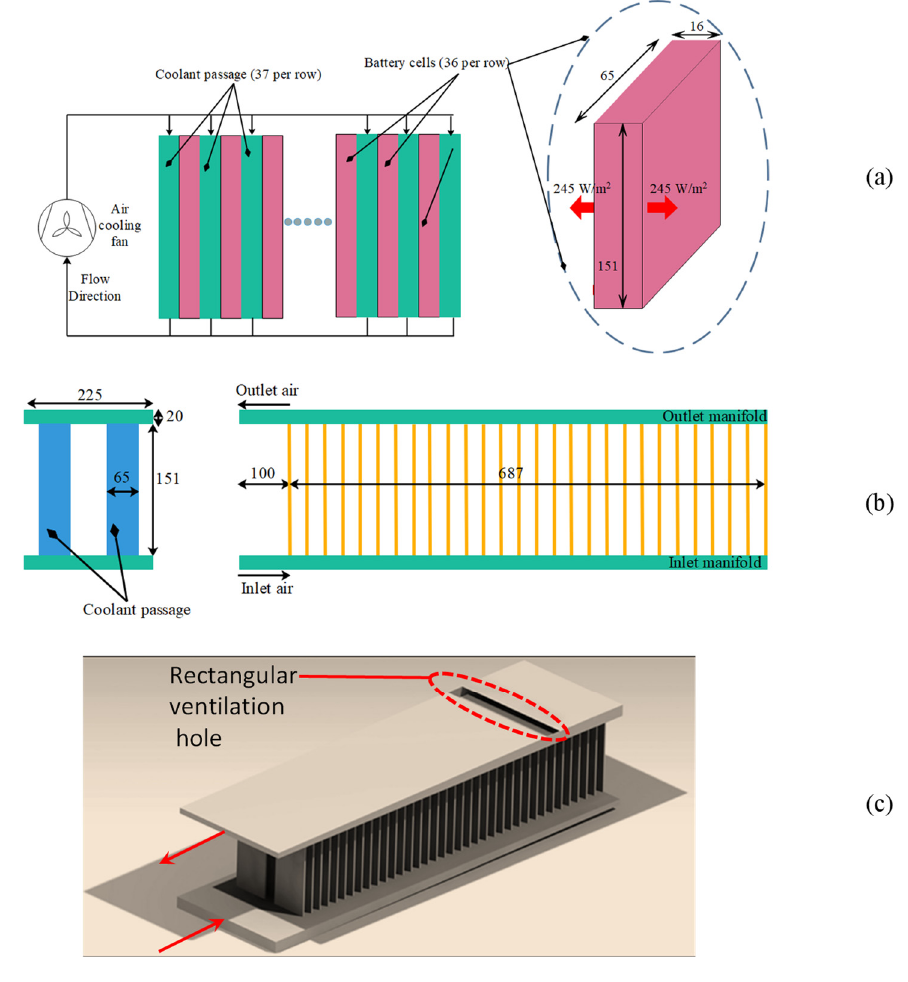
Figure 2. ( a ) Schematic diagram of battery thermal management system; ( b ) Sectional and side view of cooling system with complete specification; ( c ) Isometric diagram of type-V configuration by Park [20].